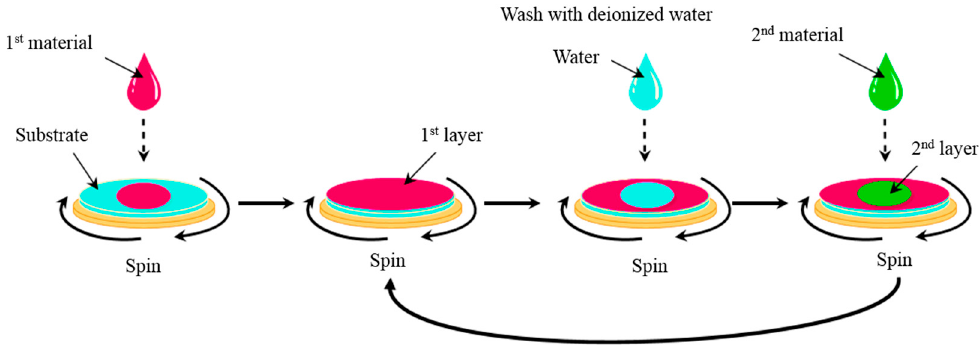
Figure 10. Schematic illustration of the spin assembly.